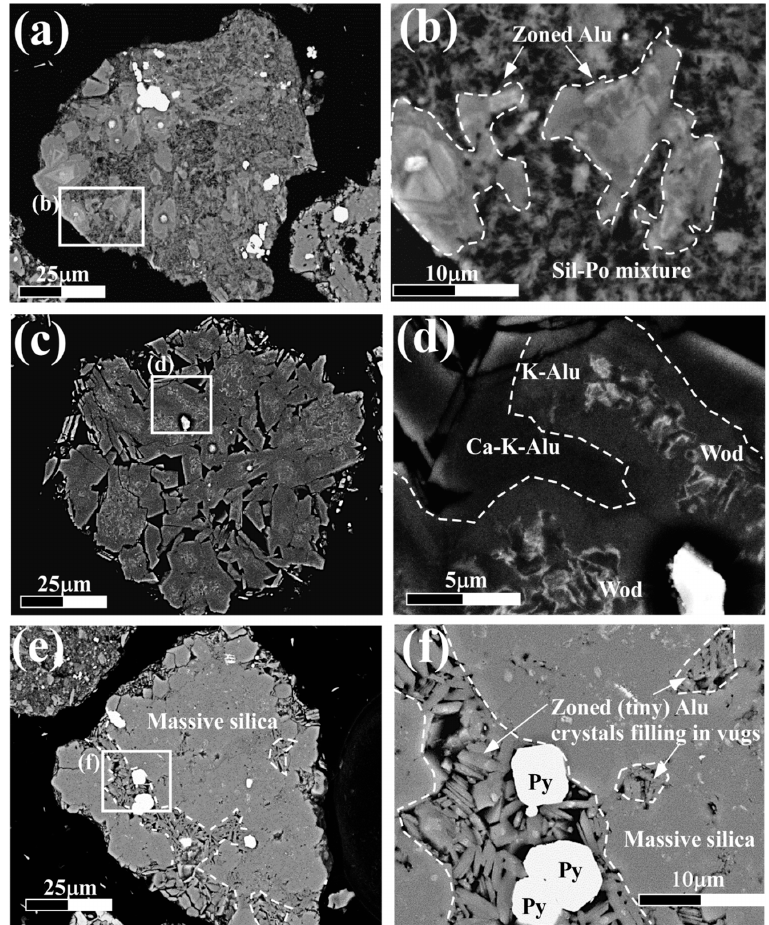
Figure 5. Representative backscattered electron images of Zoned-alunite-woodhouseite-APS . Each of (a), (c), and (e) shows the entire view of the ash grain, corresponding respectively to the magnified images of (b), (d), and (f). The mineral abbreviations are the same as in Table 1. ( a ) An aggregate of zoned-alunite crystals in the matrix of silica-pyrophyllite mixture (ONTK-VA-017 in Table 2). ( b ) A fine-grained silica-pyrophyllite mixture interstitially fills among the zoned alunite crystals with a woodhouseite core. ( c ) An aggregate of coarse zoned alunite crystals. ( d ) Zoned alunite containing a fibrous-woodhouseite core (ONTK-VA-004 in Table 2). The interstitial silica and Si-Al clay minerals are not accompanied with the zoned alunite. ( e ) Zoned alunite filling the vugs in a massive silicified rock fragment. Irregular or vein-shaped vugs are incompletely filled with tiny zoned alunite crystals (ONTK-VA-001 in Table 2). ( f ) An aggregate of tiny crystals of zoned alunite in the vugs. Micro-wormy-vein woodhouseite-APS : In this type of occurrence, the APS mineral forms a coherent single-phase in microveinlets reminiscent of the wormy texture used to describe intergrowths between quartz and advanced argillic alteration minerals, such as pyrophyllite, dickite or alunite, in porphyry copper systems of the Cajamarca region of northern Peru [53]. At Ontake a similar texture is observed in mineral mixtures of silica and woodhousite-APS or kaolinite/dickite (Figure 6a,b). The